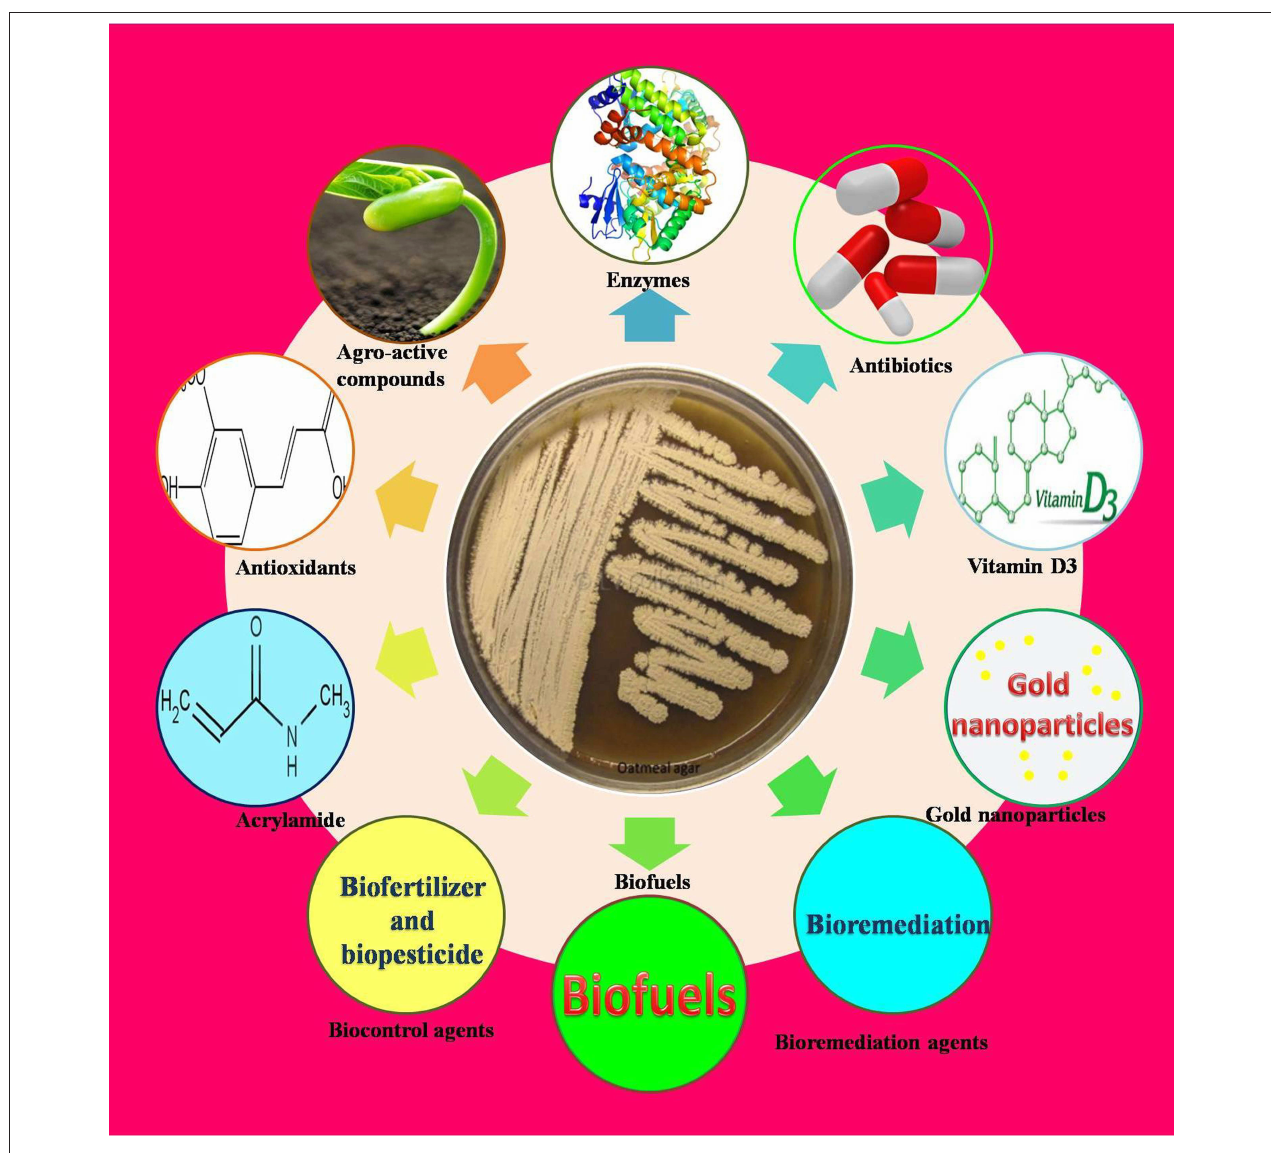
FIGURE 3 | Potential applications of Industrial thermophilic and alkaliphilic